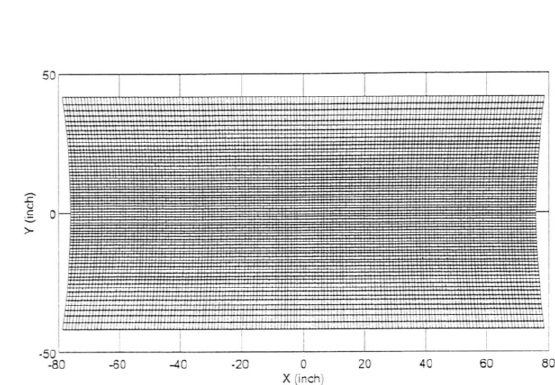
FIGURE 2 The actual data point grid appeared on the fuselage surface (66 x